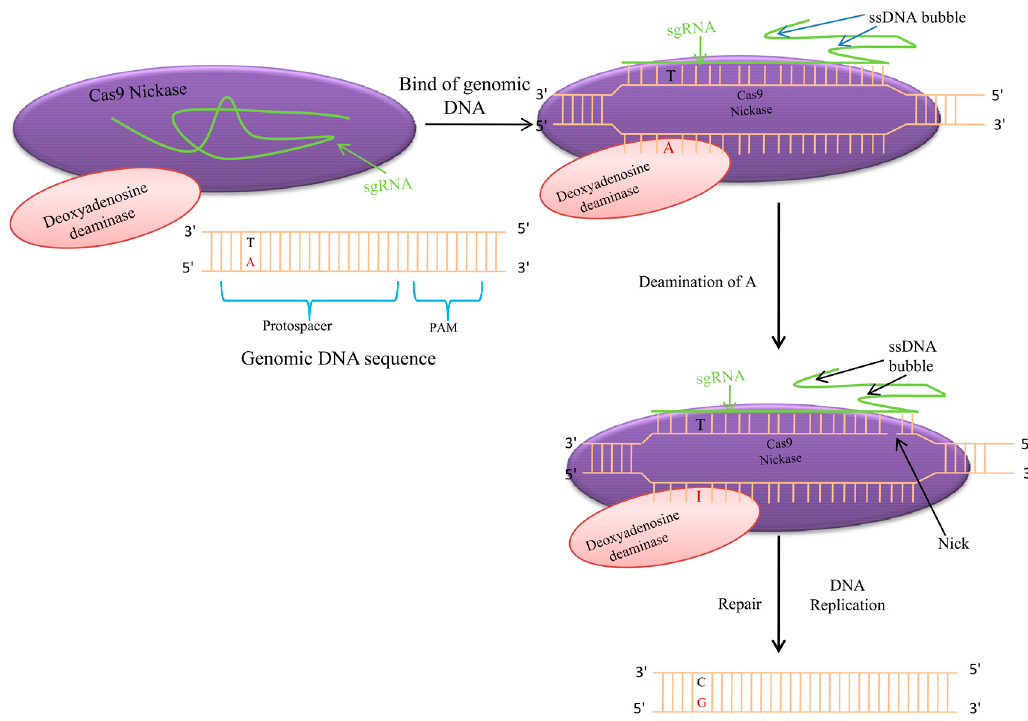
Figure 6. Adenine Base Editor (ABE). ABE mediates conversion of A-T to G-C base pairing using deoxyadenosine deaminase, catalytically impaired Cas9 nickase and a guide RNA (sgRNA). Deamination of adenine is done by deaminase by converting it to inosine (I). During polymerization, polymerase reads I as guanosine (G) and subsequently A-T is replaced by G-C. ssDNA: single stranded DNA